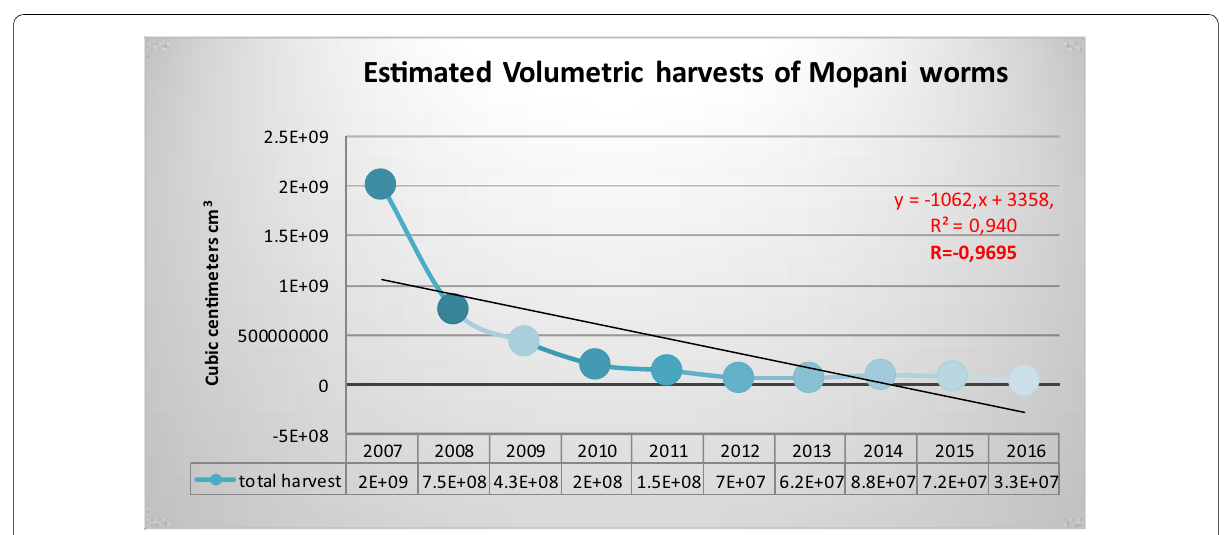
Fig. 5 Estimated volumetric harvests of Mopani